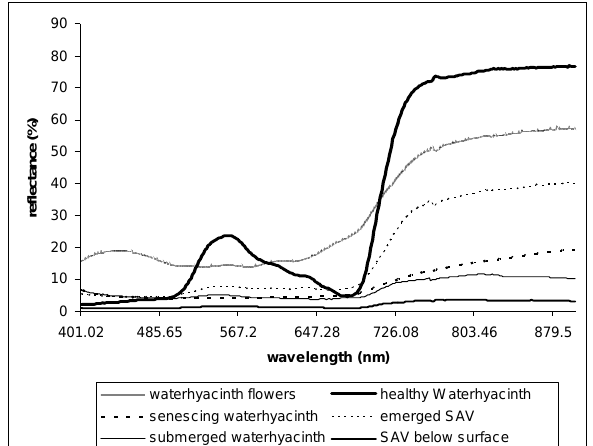
Figure 4 : Spectral reflectance (%) of the floating waterhyacinth and submerged aquatic vegetation (SAV).